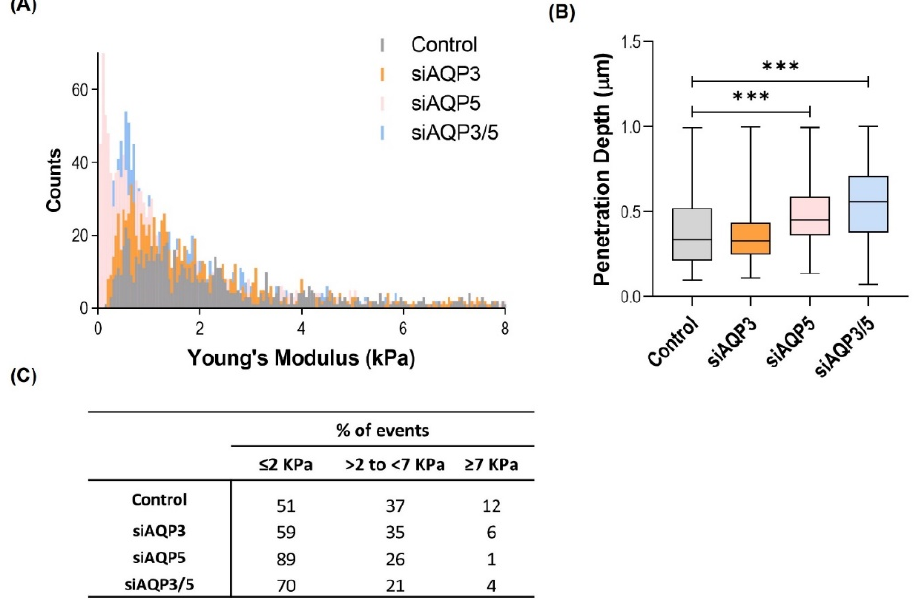
Figure 4. Biomechanical properties of BxPC-3 cells. ( A ) Young’s modulus. ( B ) Tip penetration depth into the cells. ( C ) Percentage of events at different Young’s modulus classes. Results were obtained in three independent experiments, with at least 600 force curves analyzed in each of them. *** p < 0.001, silenced vs. control cells.